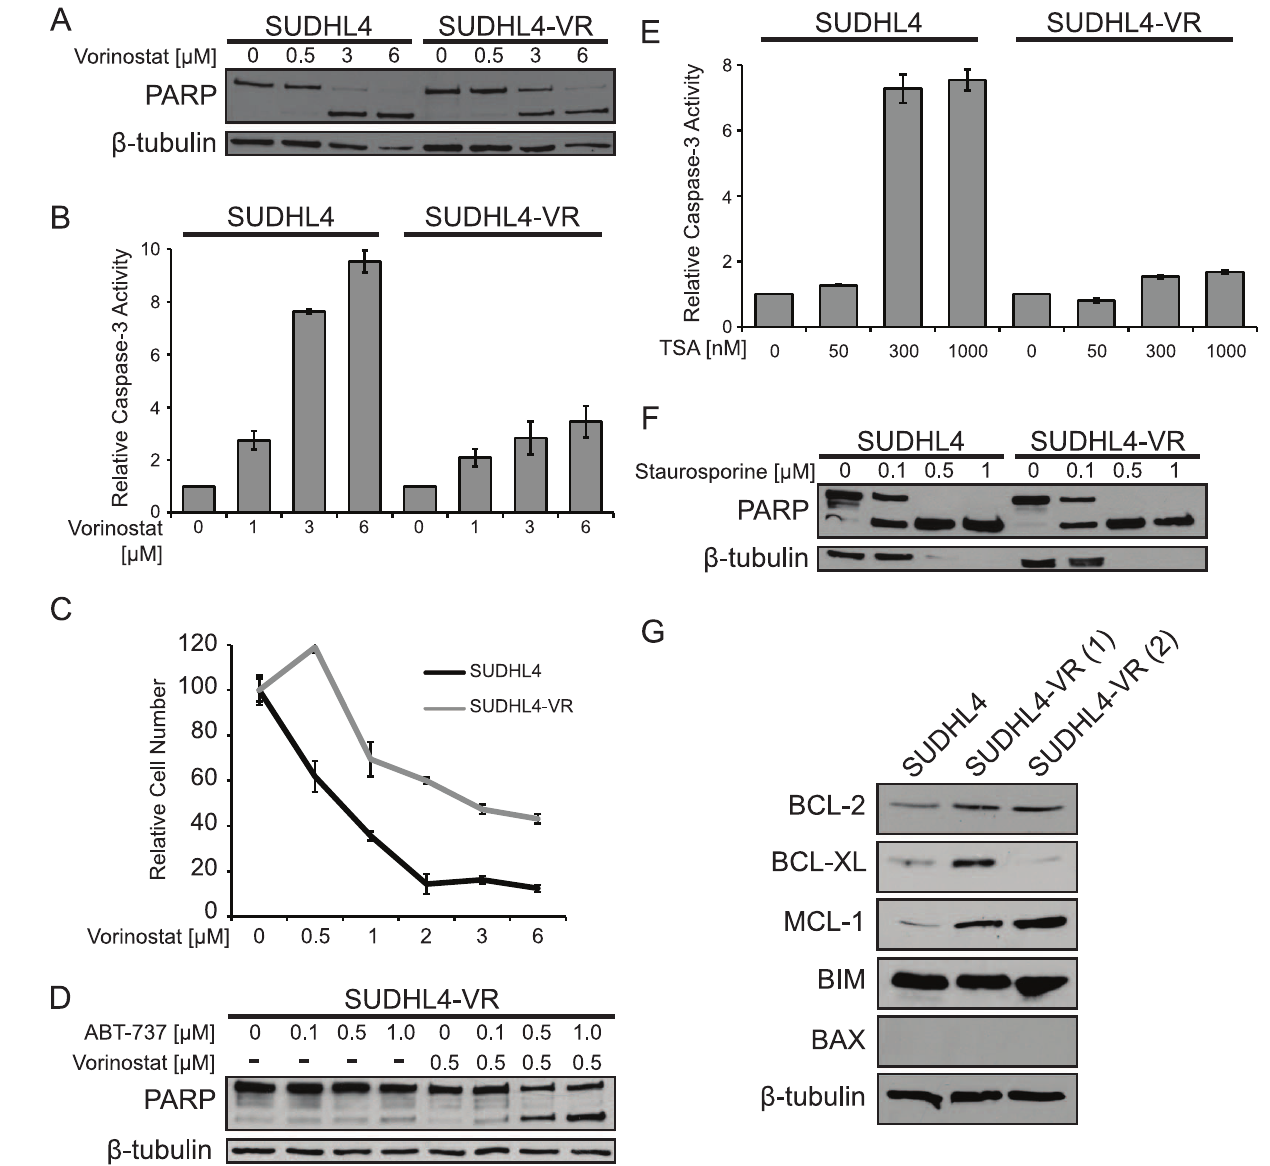
Figure 5. SUDHL4 cells selected for vorinostat resistance show decreased sensitivity to vorinostat-induced apoptosis and cell proliferation inhibition. ( A ) SUDHL4 and SUDHL4-VR cells were treated for 24 h with the indicated concentrations of vorinostat. PARP cleavage and b -tubulin (as a normalizing control) were assessed by Western blotting of whole-cell extracts. ( B ) Relative caspase-3 activity was measured in cells treated for 14 h with the indicated concentrations of vorinostat. The values represent the average relative fluorescence as compared to untreated samples (1.0) from three independent assays. Error bars indicate standard error. ( C ) Growth inhibition by vorinostat was assessed by treating SUDHL4- VR cells with increasing amounts of vorinostat for 72 h, and then counting cells using a hemocytometer. The relative numbers of cells are percentages as compared to cells incubated for the same amount of time in the absence of vorinostat. The results are the averages of three separate treatment samples. Error bars indicate standard deviation. ( D ) SUDHL4-VR cells were treated with the indicated concentrations of ABT-737 with and without a sub-optimal level (0.5 m M) of vorinostat. Whole-cell extracts were subjected to Western blotting for PARP cleavage and b -tubulin levels (as a normalizing control). ( E ) Relative caspase-3 activity was measured in cells treated for 14 h with TSA as indicated. The values represent the average relative fluorescence of three independent assays as compared to untreated samples. Error bars indicate standard error. ( F ) Cells were treated for 24 h with the indicated concentrations of staurosporine. PARP cleavage and b -tubulin (as a normalizing control) were assessed by Western blotting of whole-cell extracts. ( G ) Western blotting for the indicated BCL-2 family members in parental SUDHL4 cells and in two independent populations of SUDHL4-VR cells (1 and 2). b -tubulin was used as a protein loading control. The SUDHL4-VR(1) cell line was used for experiments in panels A–F. is increased rapidly following vorinostat treatment in the HDACi - resistant SUDHL6 cell line (Fig. 2F), it is important to note that SUDHL6 cells have levels of constitutive BIM that are more than 10-fold lover than HDACi-sensitive SUDHL4 cells (see Fig. S1).